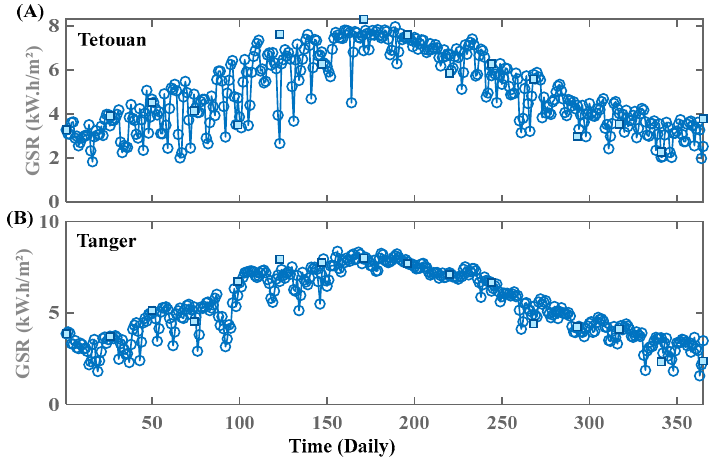
the highest solar radiation months over the year were from May to July, while the lowest values were from December to January.